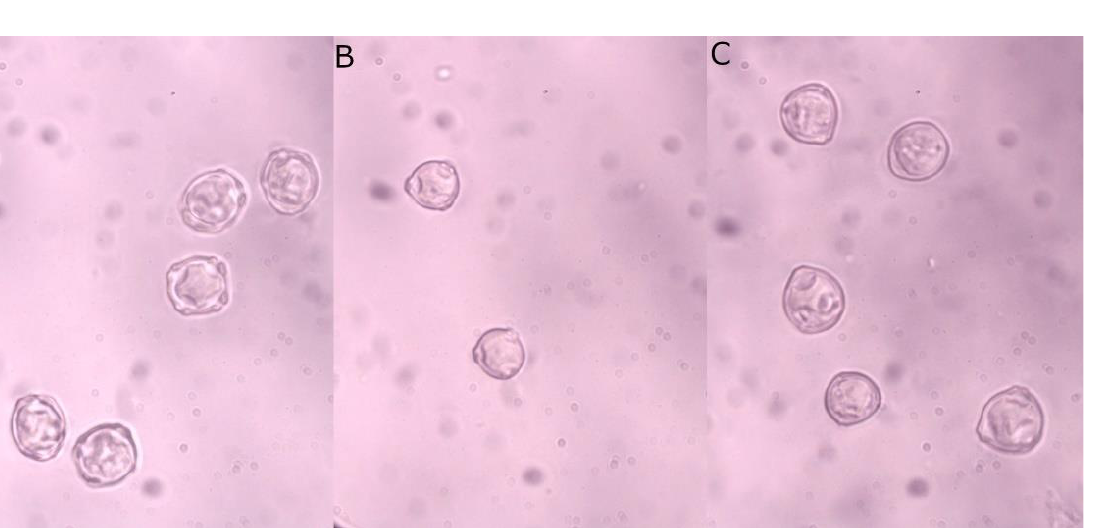
Figure 1. Examples of microscopic images of ( A ) Alnus , ( B ) Betula , and ( C ) Corylus pollen grains.